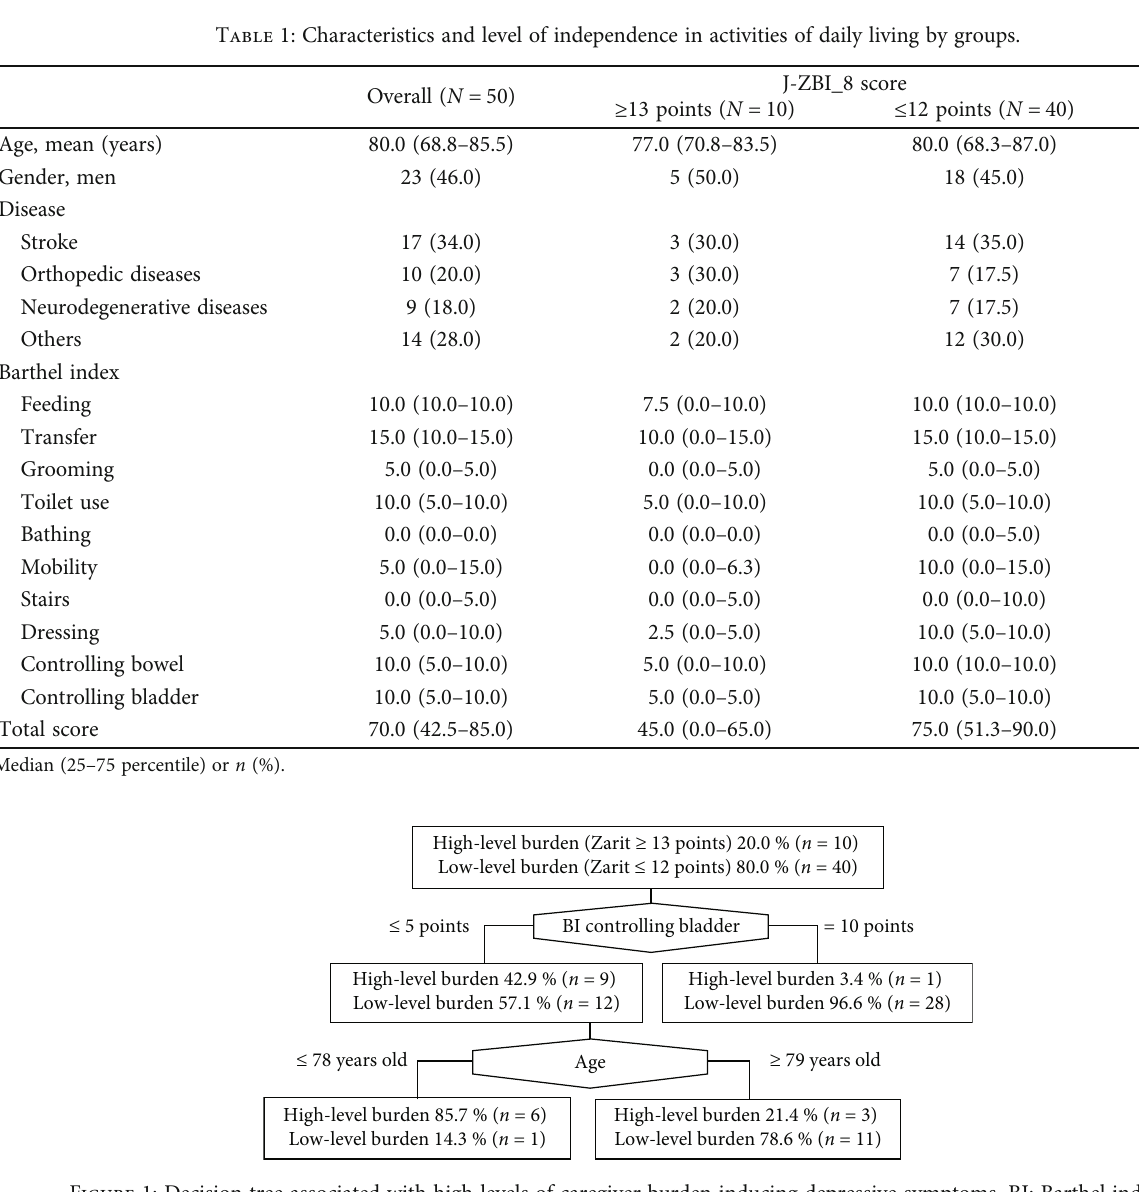
Figure 1: Decision tree associated with high levels of caregiver burden inducing depressive symptoms. BI: Barthel